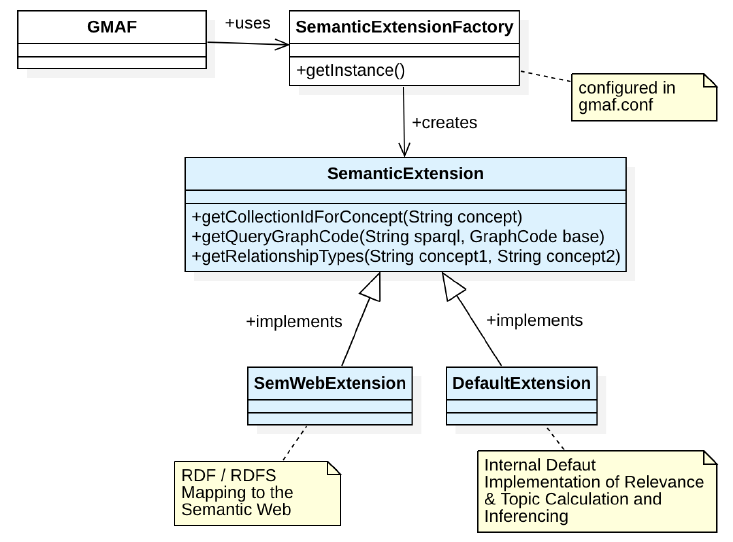
Figure 10. Factory implementation to attach external semantic frameworks.